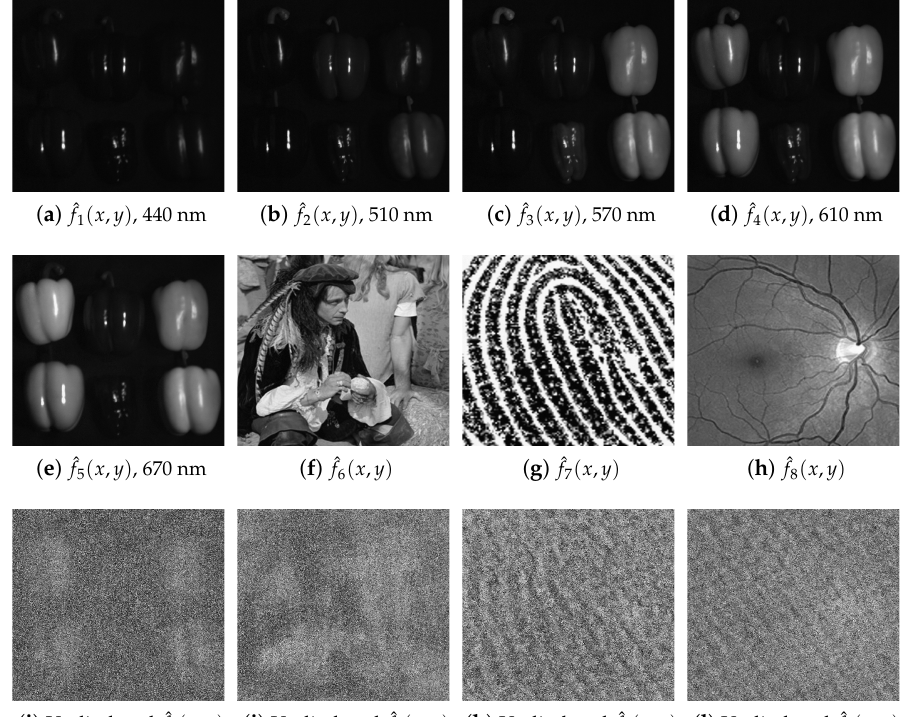
Figure 4. ( a – h ) Correct decrypted images ˆ f j ( x , y ) at j = 1,2,3,...,8, when the correct seventeen security keys RPMs, given by the sixteen RPMs ( r j ( x , y ) and h j ( x , y ) ) and the rotation angle of the GT operator, are used. ( i – l ) Wrong decrypted images ˆ f 5 ( x , y ) , ˆ f 6 ( x , y ) , ˆ f 7 ( x , y ) and ˆ f 8 ( x , y ) , respectively, when the incorrect security key RPM h 7 ( x , y ) and the other correct sixteen security keys (the remaining fifteen RPMs and the rotation angle of the GT operator) are used in the decryption